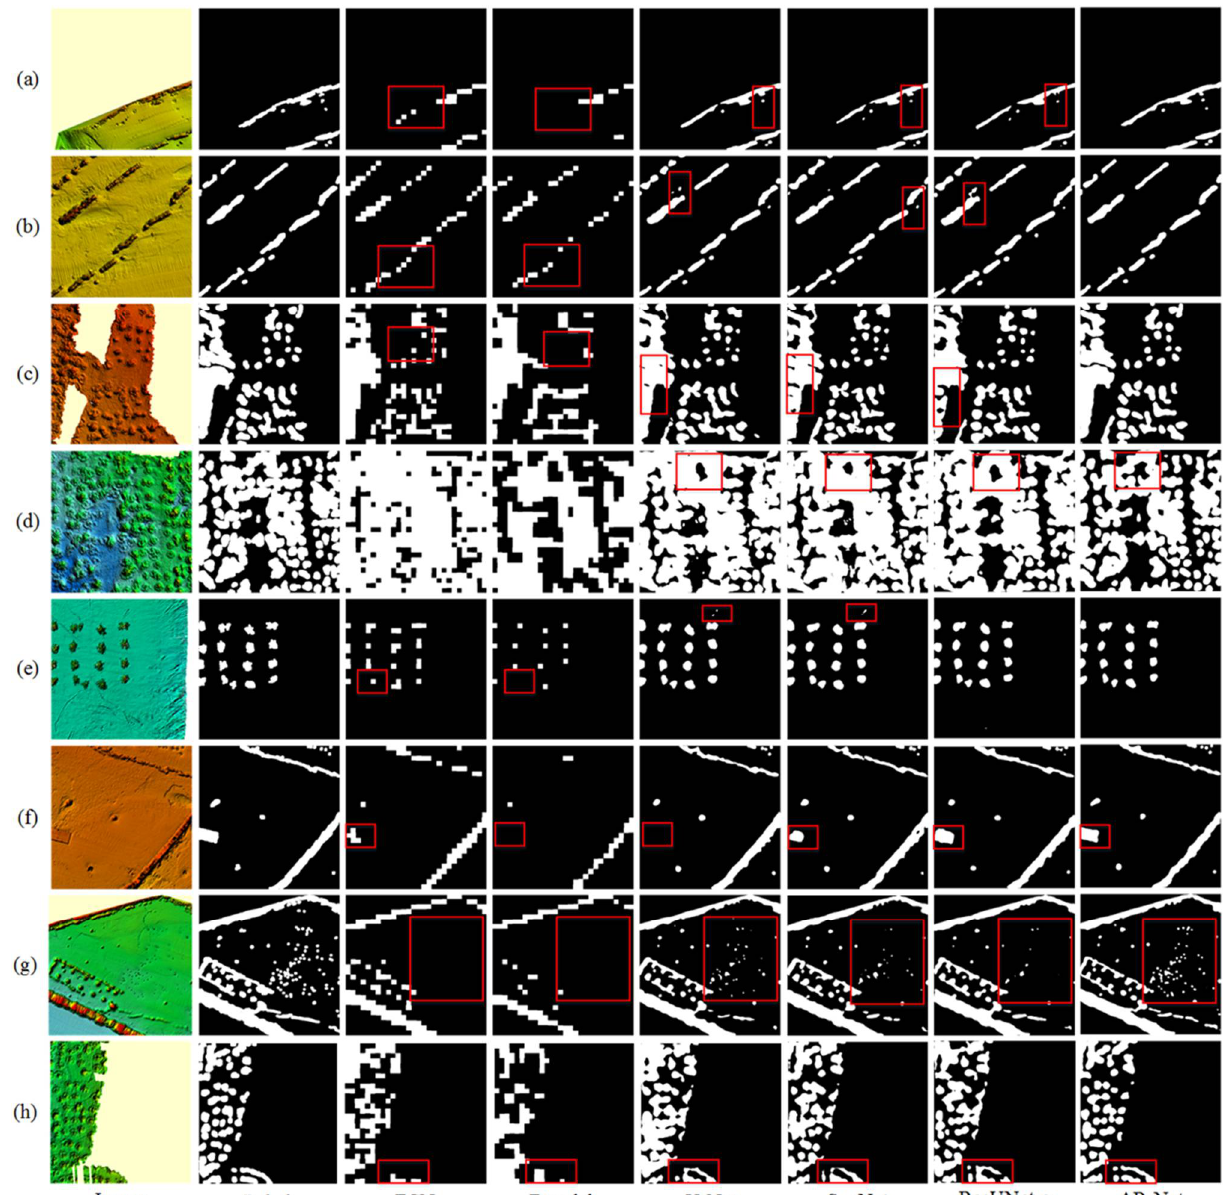
Figure 5. The artificial reef detection results of the six semantic segmentation algorithms for the multibeam sonar images in the FIO-AR dataset. ( a – h ) The first two columns are the multibeam sonar images and ground-truth labels in the FIO-AR dataset, respectively. The next six columns are the artificial reef detection results of the FCN, Deeplab, U-Net, SegNet, ResUNet-a and AR-Net, respectively. The red rectangles represent the key comparison areas of the algorithm